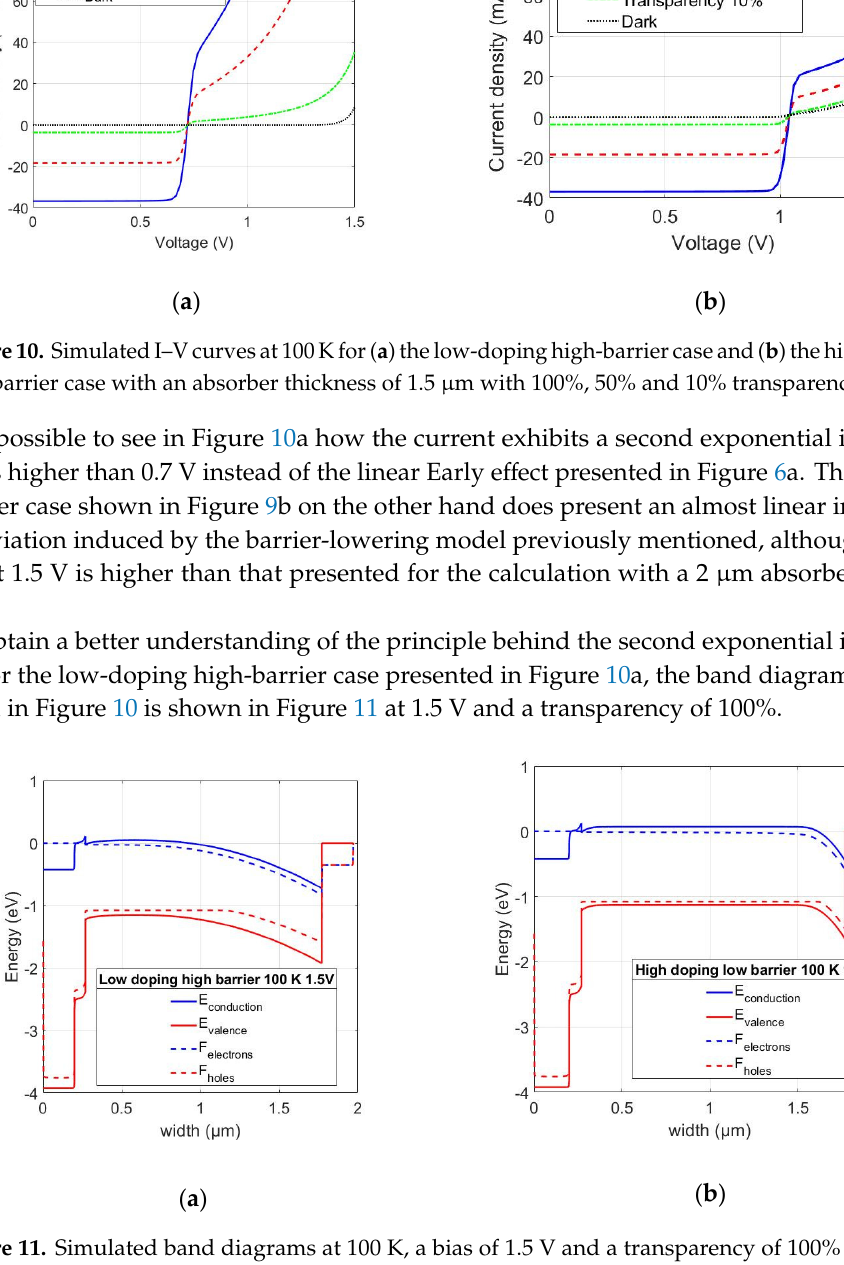
Figure 9. Simulated J–V curves at 100 K for ( a ) the low-doping high-barrier case and ( b ) the high- doping low-barrier case with no barrier lowering (red) and with barrier lowering (blue), and with 100% illumination (continuous lines) and 0% illumination level (dotted lines).